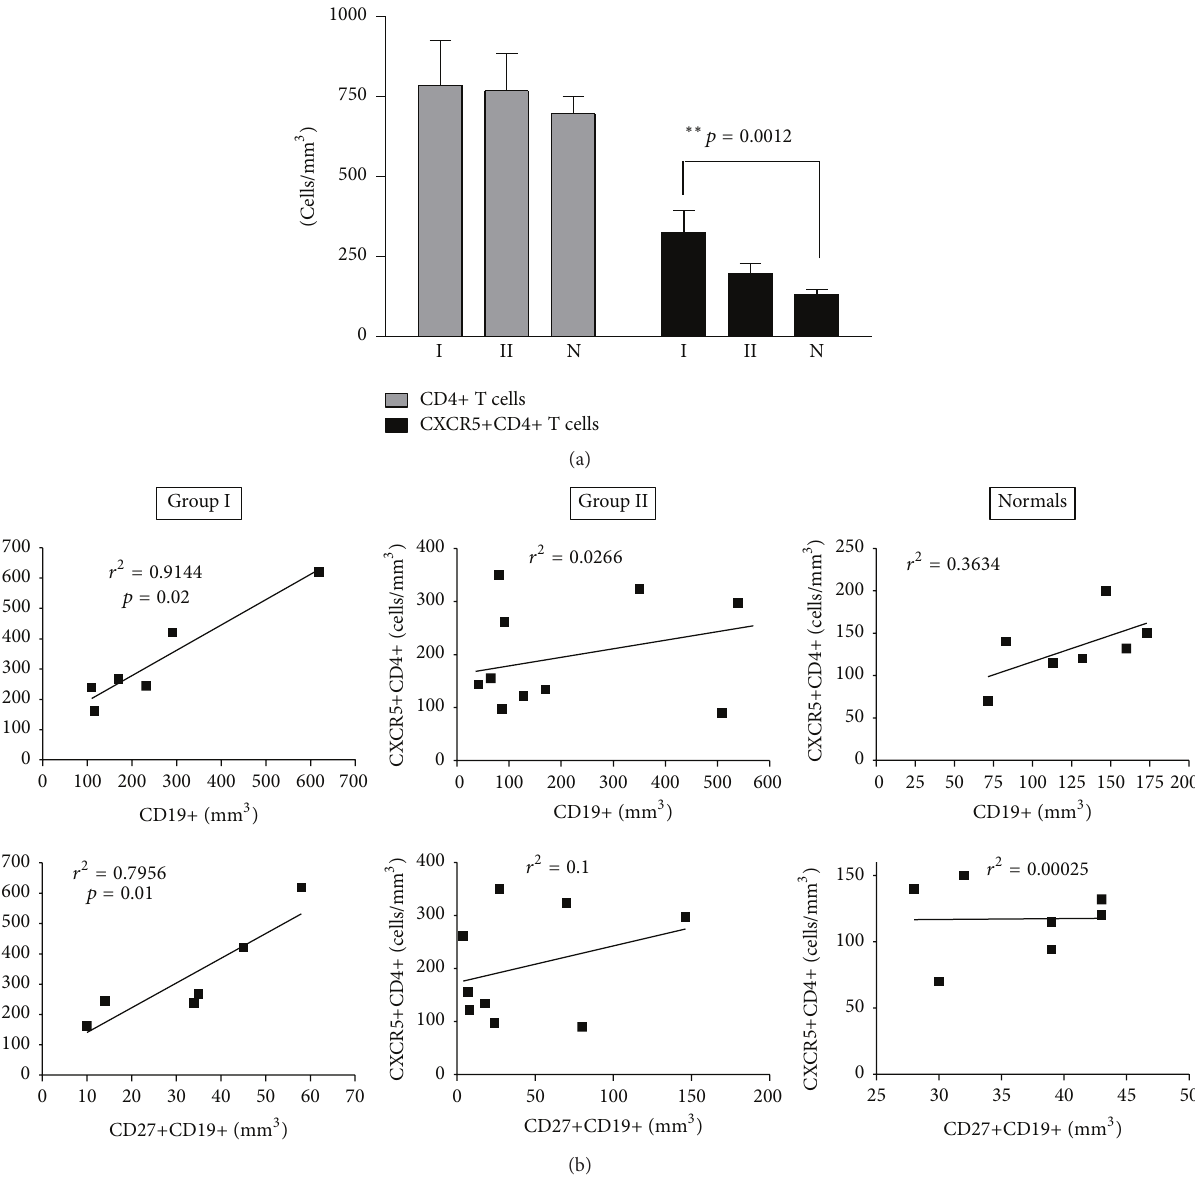
Figure 1: T FH and B lymphocyte absolute values in CVID and N. (a) Absolute lymphocyte values (cells/mm 3 ) were calculated in CVID Group I, 𝑛 = 8 (I), and Group II, 𝑛 = 13 (II), patients and control donors (N), 𝑛 = 19 . Peripheral blood was stained with monoclonal antibodies and absolute values of viable CD4+ T lymphocytes and CD4+ T cells coexpressing CXCR5 (T FH ) were calculated after analysis on a FACScan Becton Dickinson flow cytometer. (b) A comparison between peripheral blood viable B lymphocytes (CD19+ cells), memory B lymphocytes (CD27+CD19+ cells), and T FH values (CXCR5+CD4+ cells) was done in CVID Group I, Group II, and N controls. Lineal regression analysis was consigned in the graphs. Only in Group I was the correlation statistically